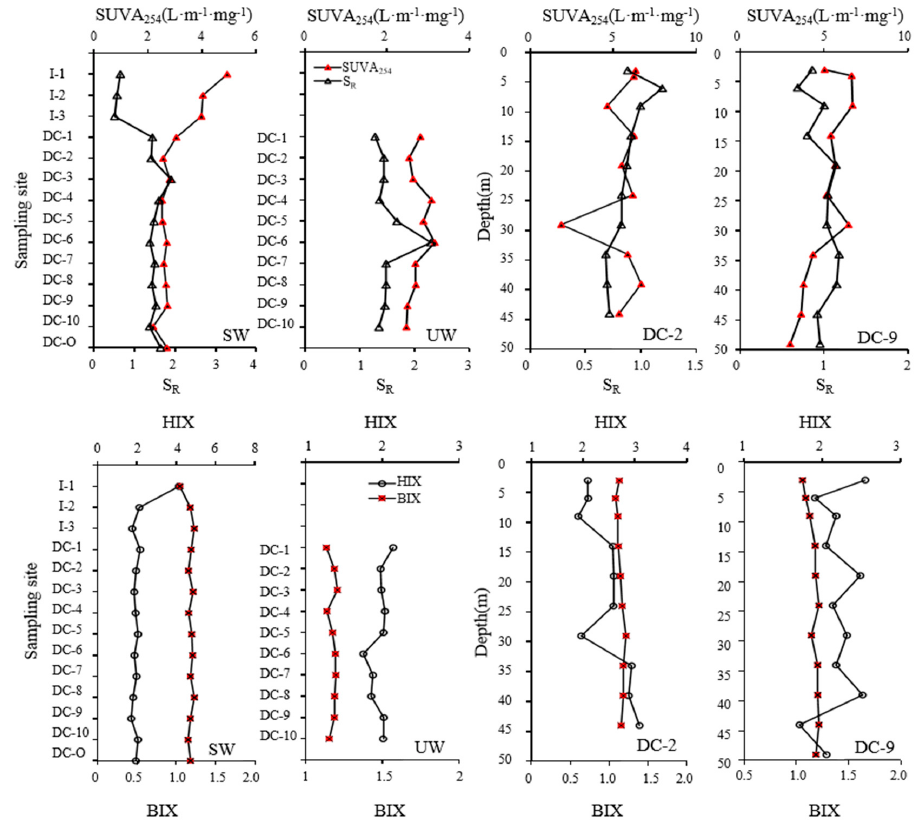
Figure 6. The characterization of aromaticity and molecular weight of DOM in horizontal and vertical watercourses in Dianchi Lake. S R : the absorption spectral slope ratio. HIX: humification index. BIX: biological index.